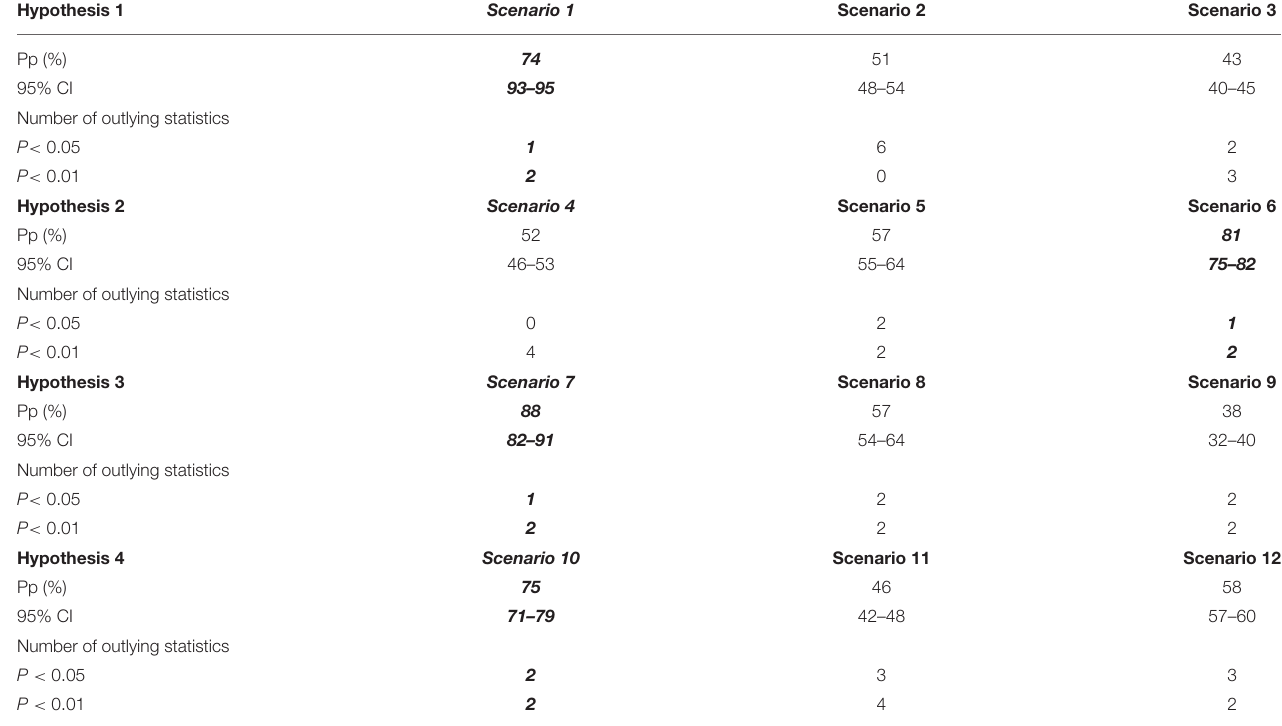
TABLE 2 | Summary of ABC results to define the most likely scenarios belonging to four hypotheses about the gene flow of grapevine genetic resources from